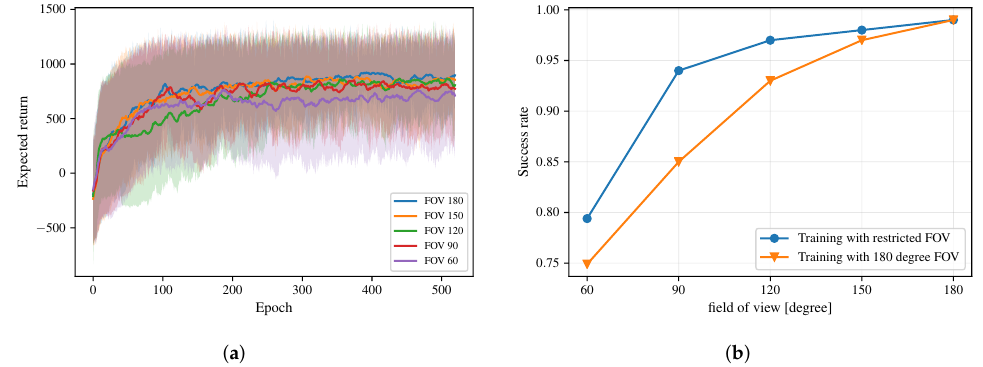
Figure 12. ( a ) Comparison of expected returns of the trained Map-based policies for sensors with different Fields of View (FOVs). ( b ) Comparison of the success rate between the trained Map-based policy with specific restricted FOVs and that with 180-degree FOV. training with specific restricted FOV and the Map-based policy training with 180-degree FOV in the new random